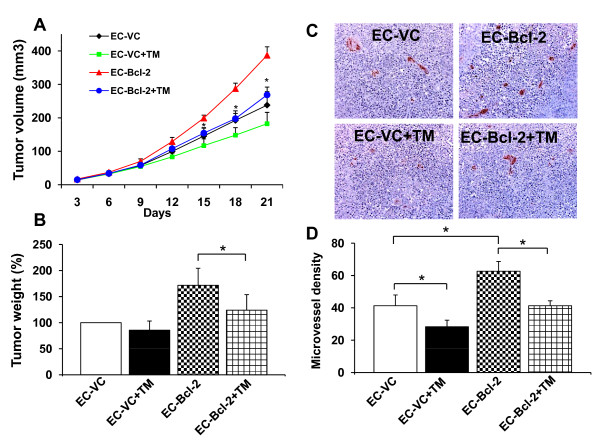
Tetrathiomolybdate (TM) treatment significantly inhibits HNSCC tumor growth and tumor angiogenesis. OSCC-3 and EC-Bcl-2 or EC-VC cells were mixed with 100 μl of Matrigel and injected in the flanks of SCID mice. Tumor volume measurements began on day 3 and continued twice a week until the end of the study. Length and width were measured using a digital caliper and tumor volumes were calculated using the formula, volume (mm3) = L × W2/2 (length L, mm; width W, mm). A; tumor progression curves for different experimental groups: OSCC-3 plus endothelial cells transduced with vector alone (EC-VC); OSCC-3 plus endothelial cells transduced with vector alone and treated with TM (EC-VC+TM); OSCC-3 plus endothelial cells transduced with Bcl-2 (EC-Bcl-2); OSCC-3 plus endothelial cells transduced with Bcl-2 and treated with TM (EC-Bcl-2+TM). B; tumor weights at the end of the study. C-D; Paraffin embedded tumor sections were stained for tumor blood vessels using anti-human von Willebrand Factor antibodies. Microvessel density in the tumor samples was calculated by counting 5 random fields (x 200). *, represents a significant difference (p < 0.05) as compared to the control group.